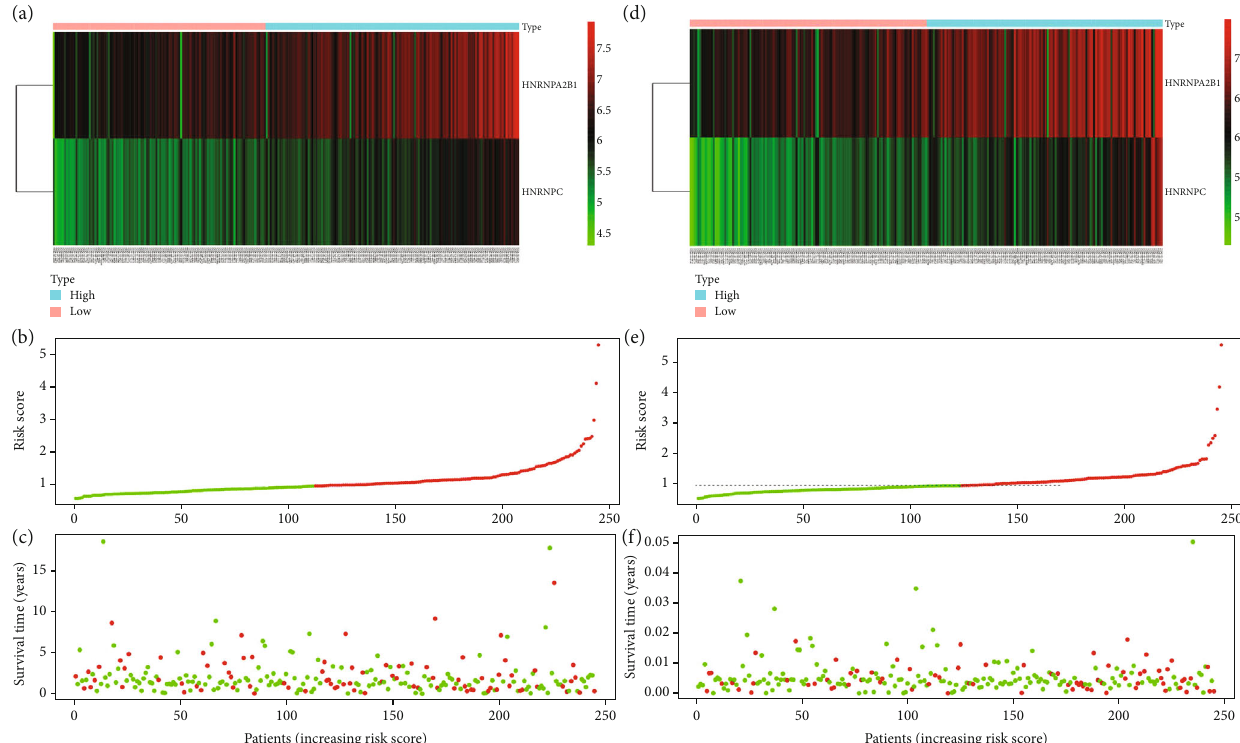
Figure 7: Distribution of risk score, OS, and OS status and heat map of the two prognostic m6A regulator signatures in the TCGA training cohort (a, b, c) and TCGA validation cohort (d, e,